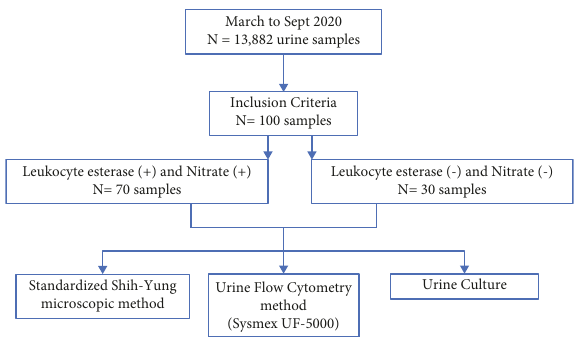
Figure 1: Flow chart of urine specimen